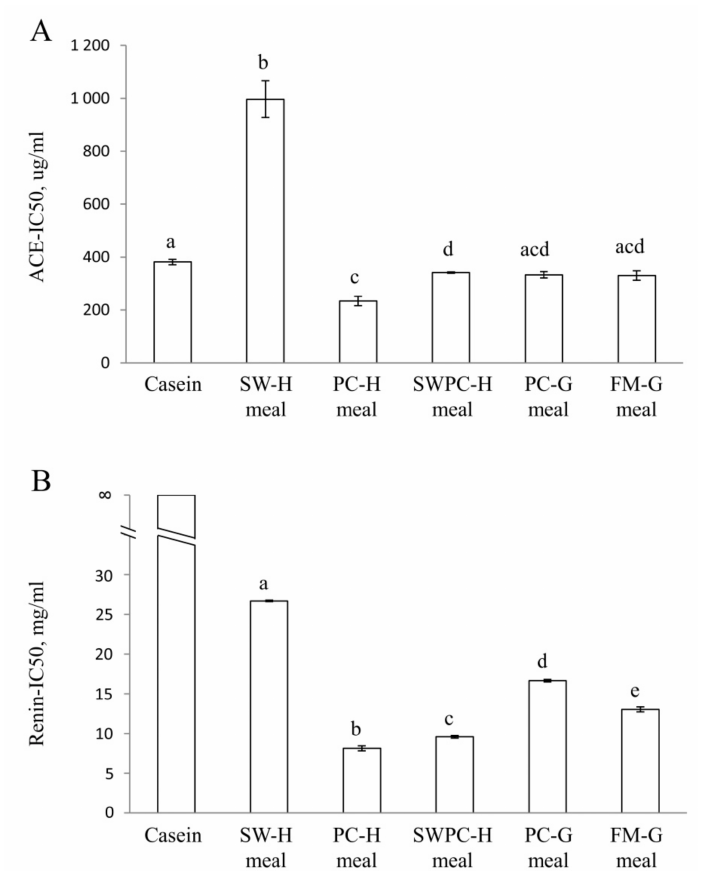
Figure 3. In vitro inhibition of activities of angiotensin-converting enzyme ( A ) and renin ( B ). Values are means, with standard error of mean represented as vertical bars. Values are shown for two or three measurements for casein and cod protein meals. Proteins are compared using one-way ANOVA with LSD post hoc test. Bars with different letters are significantly different ( p < 0.05). SW-H; stickwater from Havstrand, PC-H; presscake meal from Havstrand, SWPC-H; stickwater + presscake meal from Havstrand, PC-G; presscake meal from Granit, FM-G; fillet meal from Granit. Table 3. Bodyweight at baseline and growth at time of euthanasia, and energy intake at day 17. p Control SW-H PC-H SWPC-H PC-G FM-G Group Group Group Group Group Group